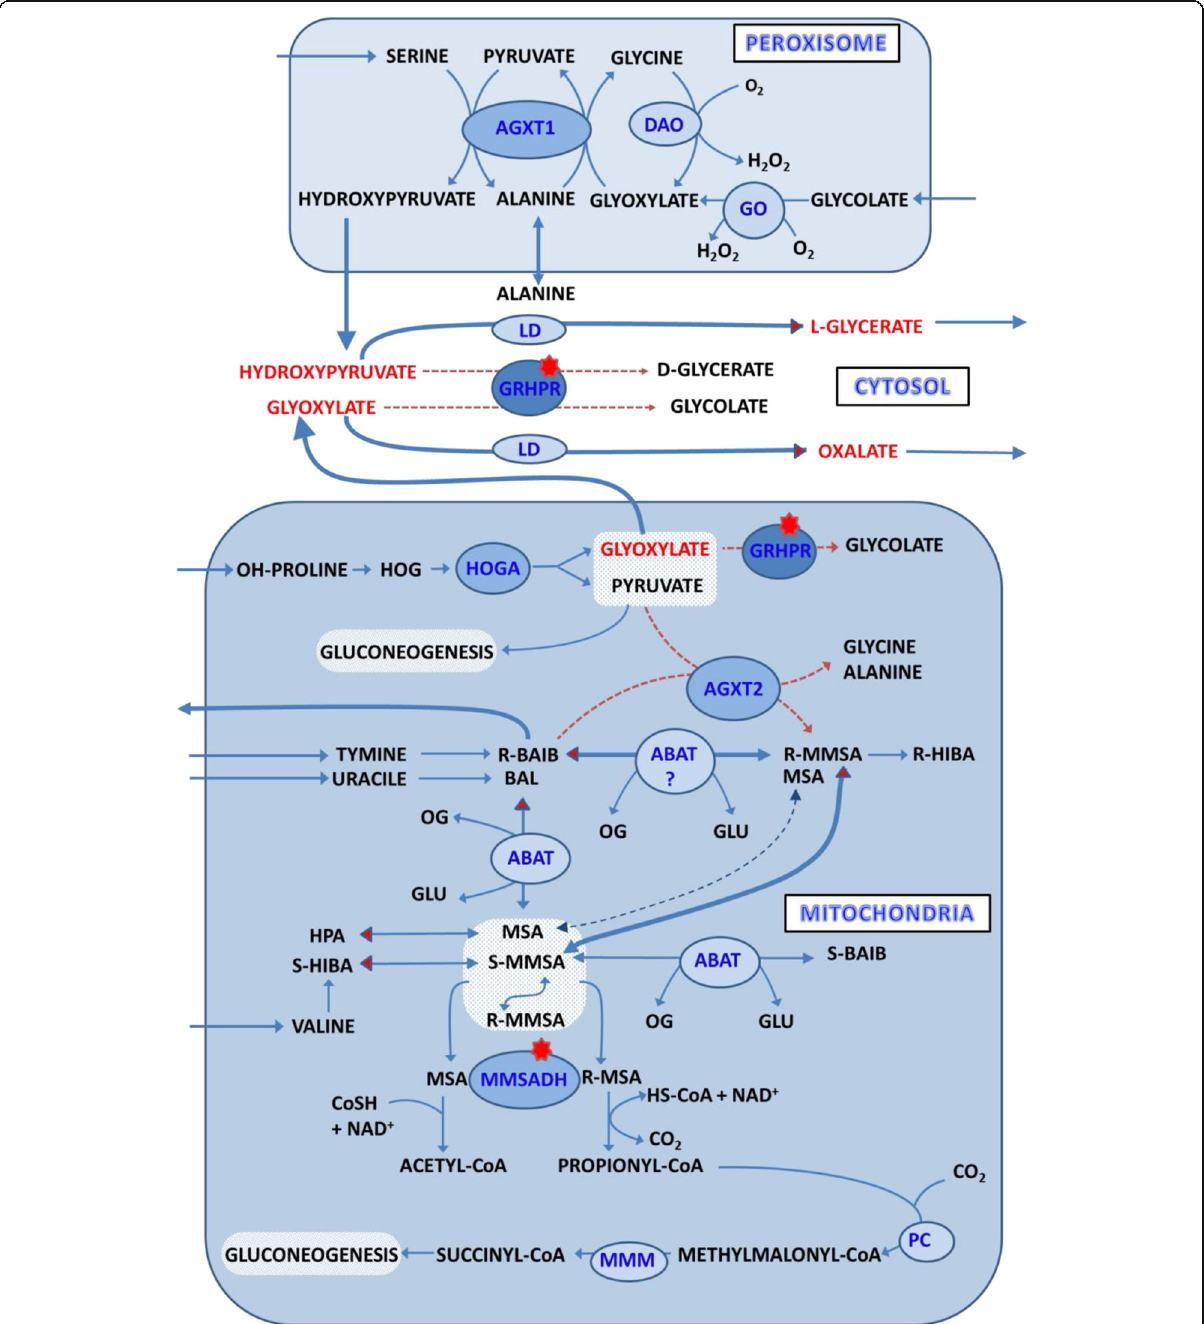
Fig. 4 The scheme showed the probably metabolic pathways in patient with PH2 and AGXT2 deficiency. The red dots indicate deficient enzymes, red dashed arrows point to the deficiency of metabolic pathway, thick blue arrows represent the overproduction of enzymes and red ends of the blue arrows point to the overproduced metabolite. Abbreviations: DAO – D-aminoacid oxidase; AGXT1 – alanine-glyoxylate aminotransferase1; GO – glycolate oxi- dase; LD – lactate dehydrogenase; HOGA - 4-hydroxy-2-oxoglutarate aldolase; AGXT2 – alanine-glyoxylate aminotransferase 2; ABAT – aminobutyrate-2- oxoglutarate; MMSADH – methylmalonyl semialdehyde dehydrogenase; MMM – methylmalonyl-CoA mutase; GRHPR - glyoxylate reductase- hydroxypyruvate reductase; PC –